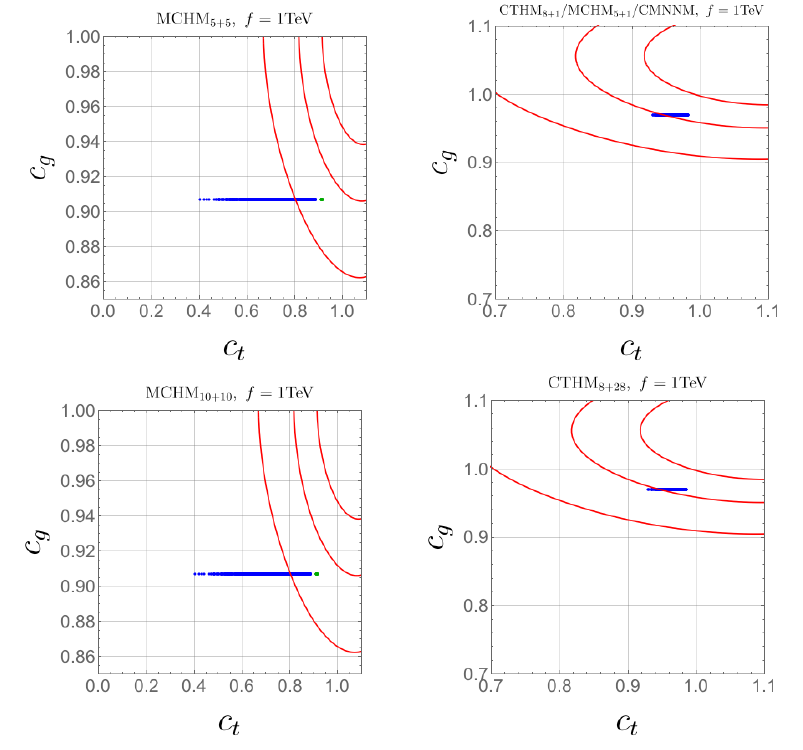
Figure 9 . The distribution of c t vs c g in models with low dimensional representations. The scale f is set to 1 TeV. The colored lines are 1 (cid:27) , 2 (cid:27) and 3 (cid:27) bounds coming from the Higgs signal global (cid:12)t using Run2 data. In MCHM, the green points predict c t > c g thus the model has the problem of triggerring EWSB [50], while the blue points satisfy c g > c t . In CTHMs, EWSB is automatically triggered as shown in section